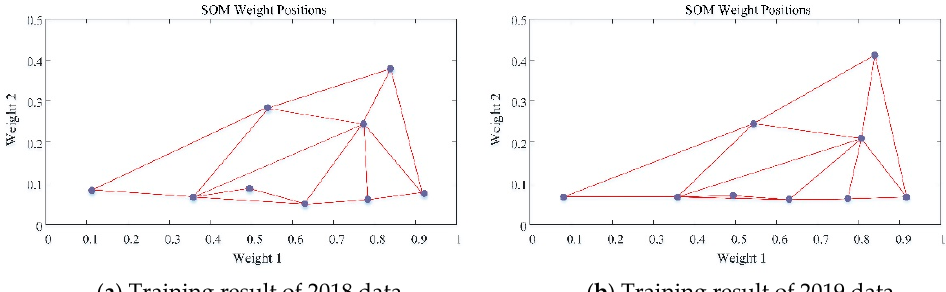
Figure 4. SOM output layer